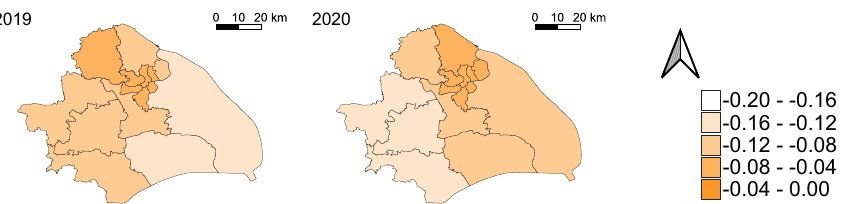
Figure 13. Average value of Dryness in each district.